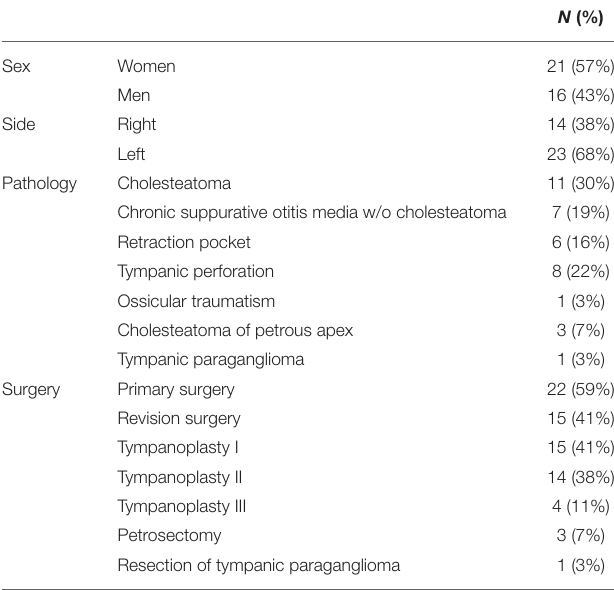
TABLE 1 | Demographic and pathological characteristics of the 37 cases in this